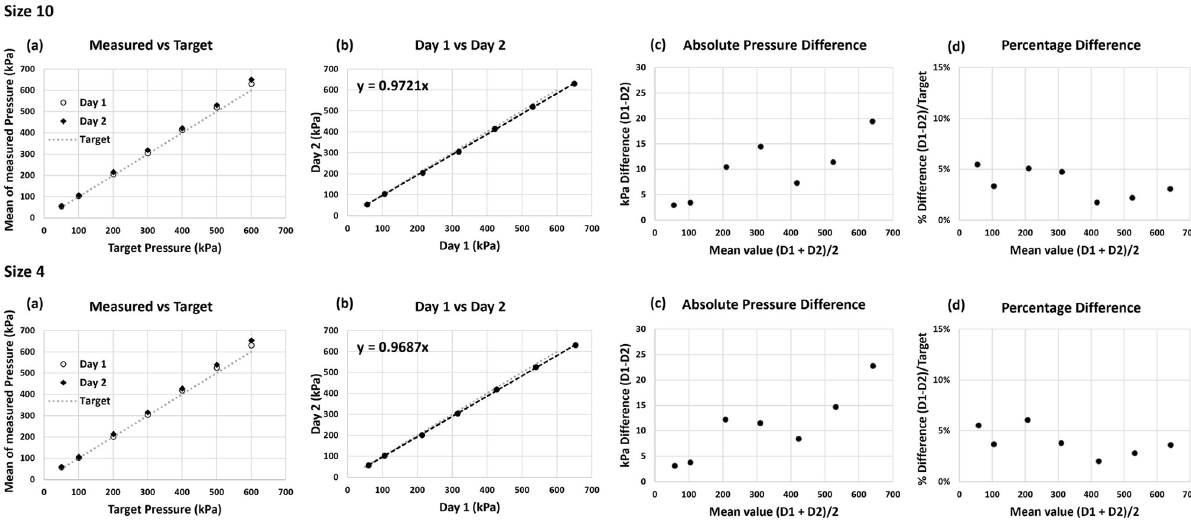
Fig 4. Peak pressure values recorded at 2s for the 7 target pressures in both insoles between days. (a) Proximity of measured values to the target (dashed line). (b) Relation between measured peak pressure on Day 1 and Day 2 showing slope of curve. (c) Average absolute difference (error) between days plotted against between day mean values (d) Average difference between days as percentage of target against between day mean values.